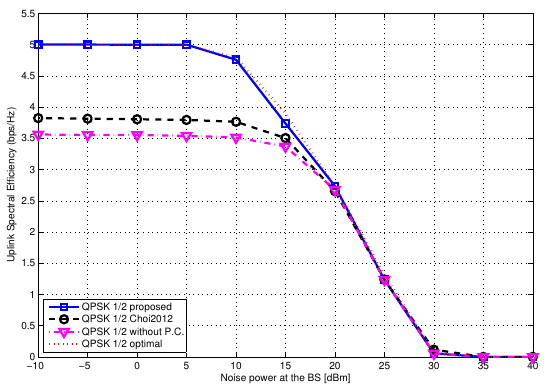
Figure 7. Spectral efficiencies for QPSK-1/2 versus noise power; U = 5 and L u = 1, ∀ u